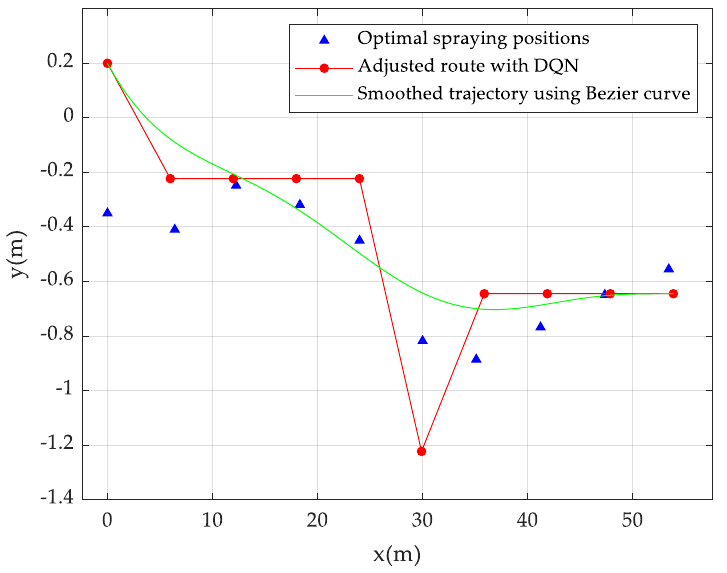
Figure 8. DQN-based UAV pesticide spraying trajectory adjustment.